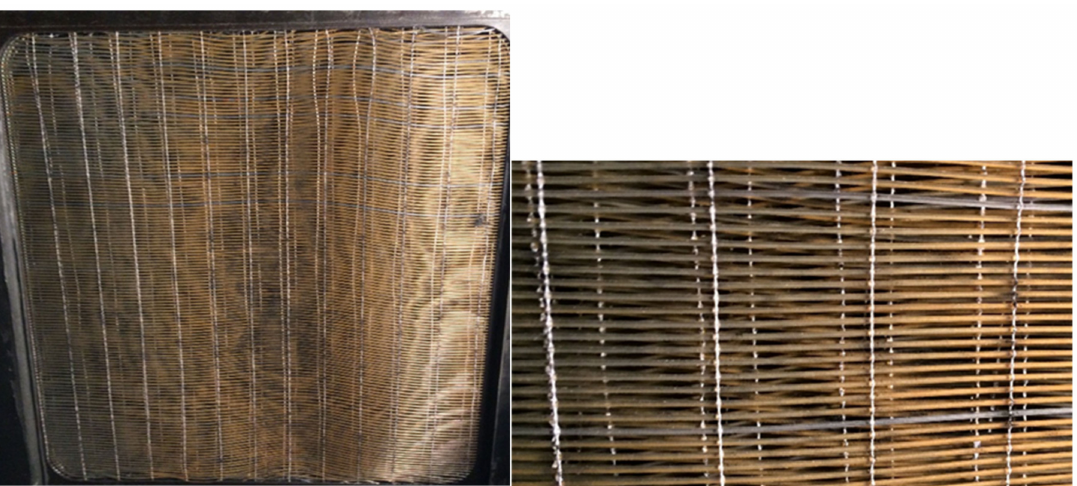
Figure 9. The back of the heat exchanger at the end of measurement. The fiber surface attaches only separated particles with no massive deposit layers.